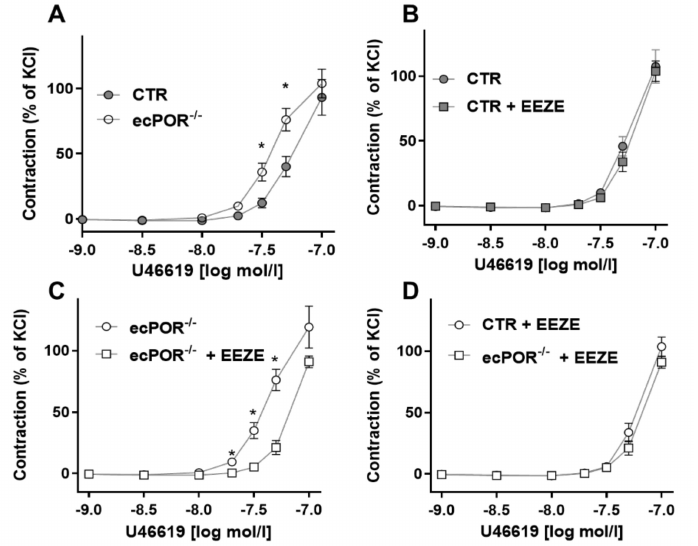
Figure 5. 14,15-EE-8(Z)-E incubation reverses the increased constriction to U46619 in the ecPOR − / − mice. Constriction of aorta from CTR and ecPOR − / − mice in response to U46619 with or without pre-incubation with 14,15 EE-8(Z)-E (24 h, 10 µ mol/L) as indicated. * p < 0.05, Two-way ANOVA with Bonferroni post-test. n ≥ 14 aortic